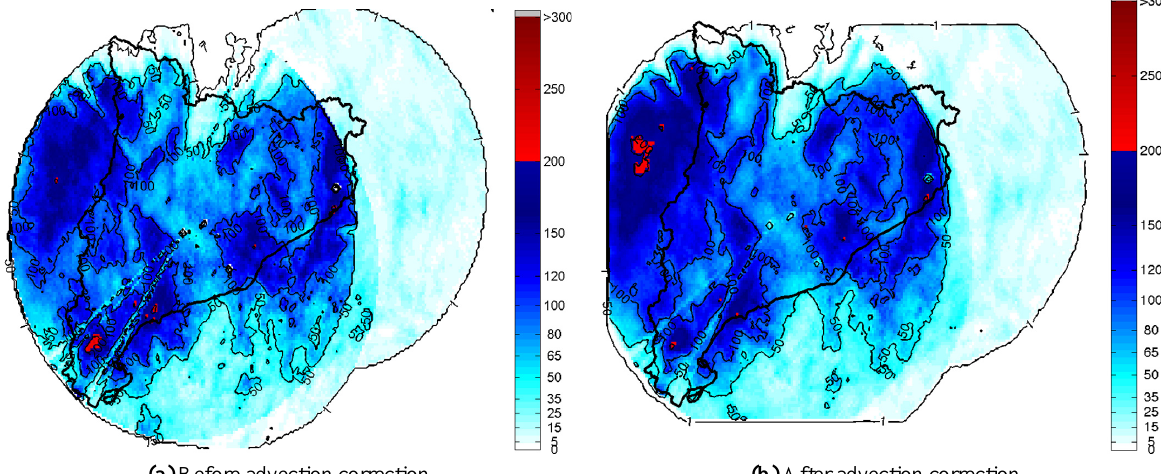
Fig. 11. Comparison between non-advected (a) and advected (b) accumulated rainfall